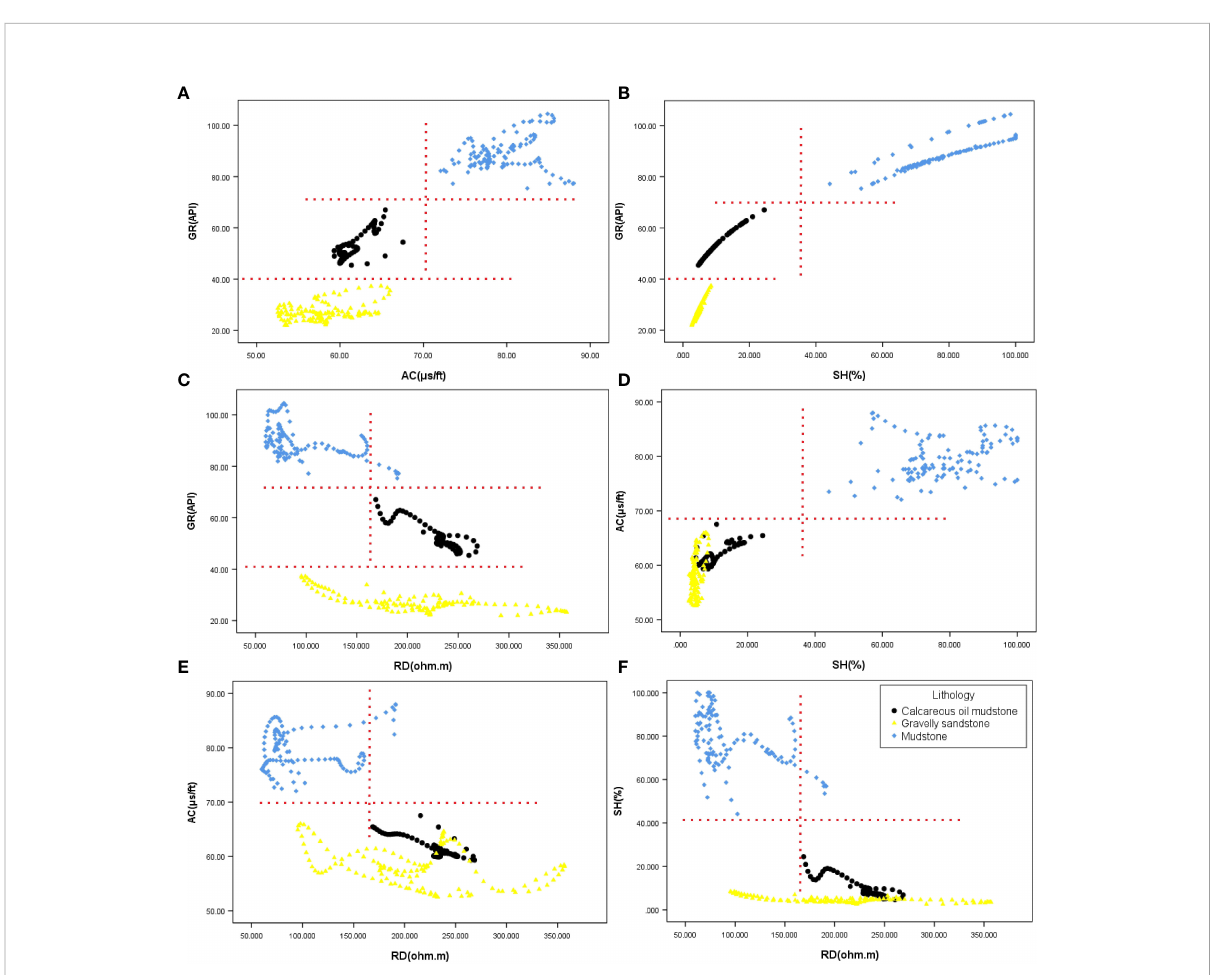
FIGURE 5 Well Che66 crossplot. (A) GR-AC crossplot; (B) GR-SH crossplot; (C) GR-RD crossplot; (D) AC-SH crossplot; (E) AC-RD crossplot; and (F) SH-RD crossplot. Figures (A – C) show that GR can effectively distinguish mudstone, calcareous oil mudstone and gravelly sandstone. Figure (A) , Figure (D) and Figure (E) show that AC can distinguish between mudstone and calcareous oil mudstone and between mudstone and gravelly sandstone, but calcareous oil mudstone and gravelly sandstone overlap greatly in value range. Figure (B) , Figure (D) and Figure (F) show that SH can distinguish between mudstone and calcareous oil mudstone and between mudstone and gravelly sandstone, but calcareous oil mudstone and gravelly sandstone overlap greatly in value range. Figure (C) , Figure (E) and Figure (F) show that RD can only distinguish mudstone and calcareous oil mudstone. There are overlapping parts between 150 and 200 ohm.m. RD cannot distinguish mudstone from gravelly sandstone. RD cannot distinguish between calcareous oil mudstone and gravelly sandstone.